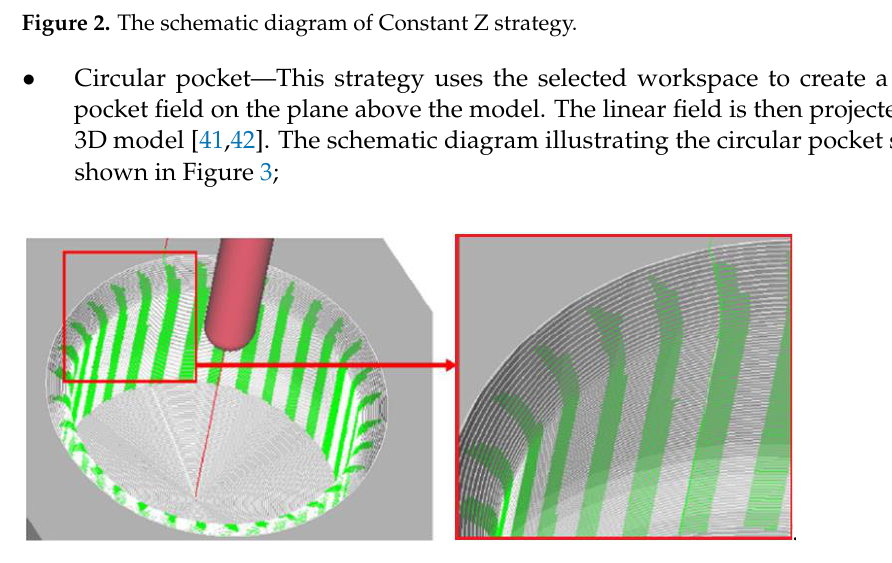
Figure 3. The schematic diagram of the Circular pocket strategy.